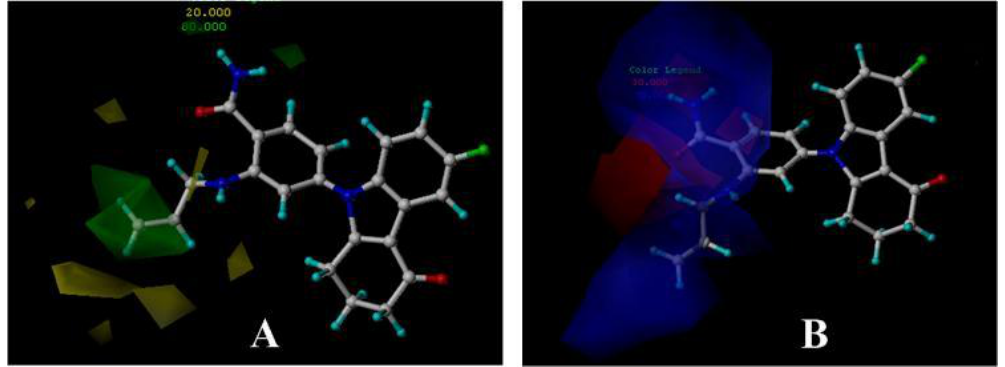
Figure 5. CoMFA StDev*Coeff contour plots for benzamide tetrahydro-4 H -carbazol-4-one analogs in combination with compound 17. ( A ) The green (sterically favorable) and yellow (sterically unfavorable) contours represent 80% and 20% level contributions, respectively; ( B ) The blue (electropositive charge favorable) and red (electronegative charge favorable) contours represent 70% and 30% level contributions, respectively.